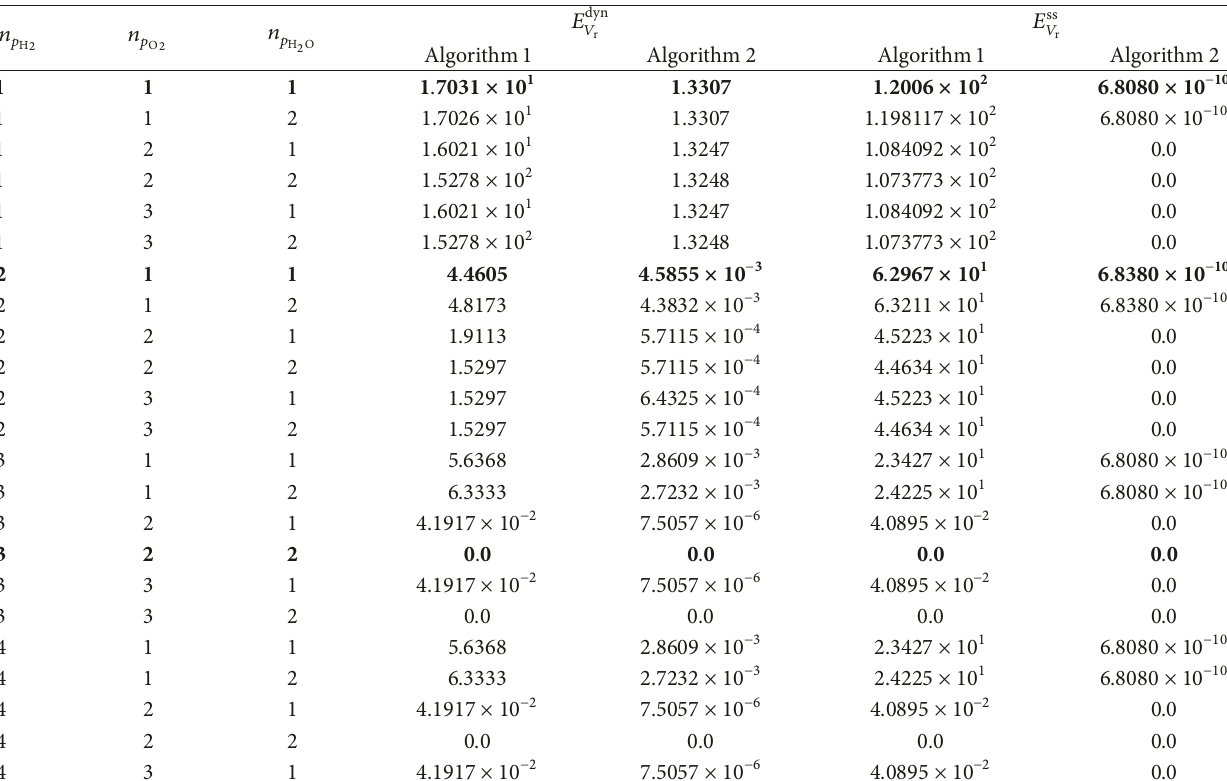
of the output variable 𝑉 r r